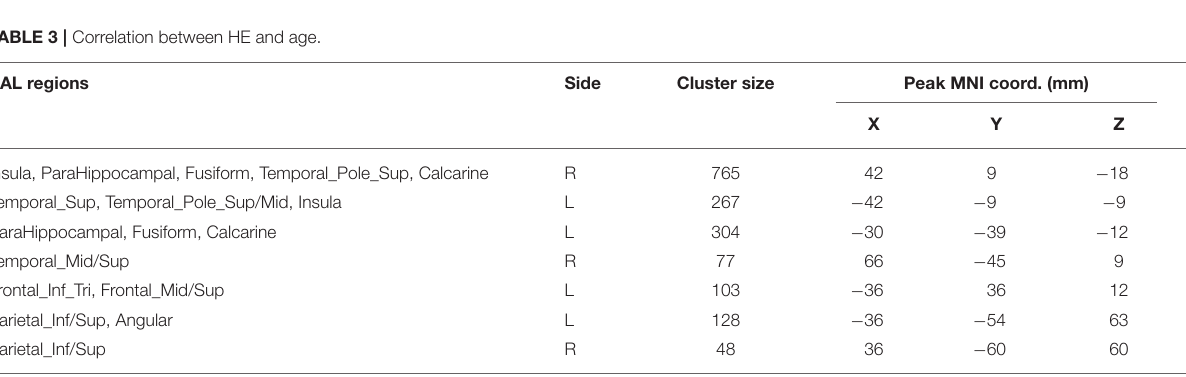
TABLE 3 | Correlation between HE and